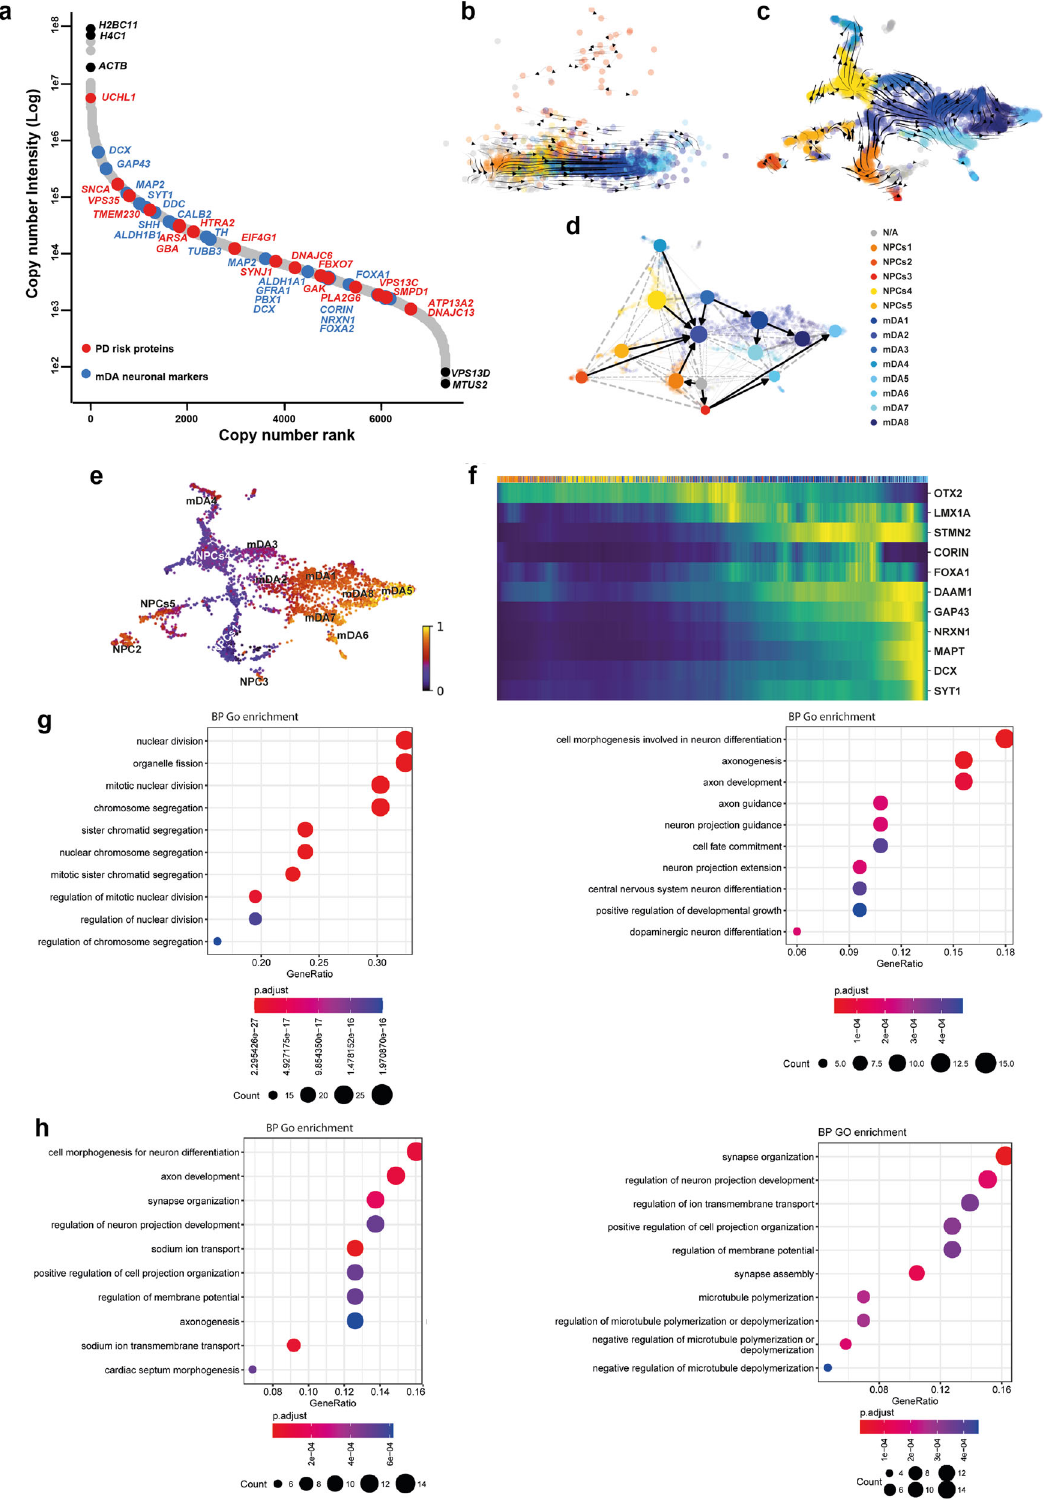
panel, Fig. 4c). As early as day 27 of differentiation, prior to functional neuronal identity, both A53T and SNCA x3 cells displayed a signi fi cantly higher number of aggregates per cell (Fig. 4d and Supplementary Fig. 6d) (Ctrl = 22 ± 3.1, A53T = 127 ± 18.2, SNCA x3 = 71 ± 16.7, P < 0.005). In addition, the average length of